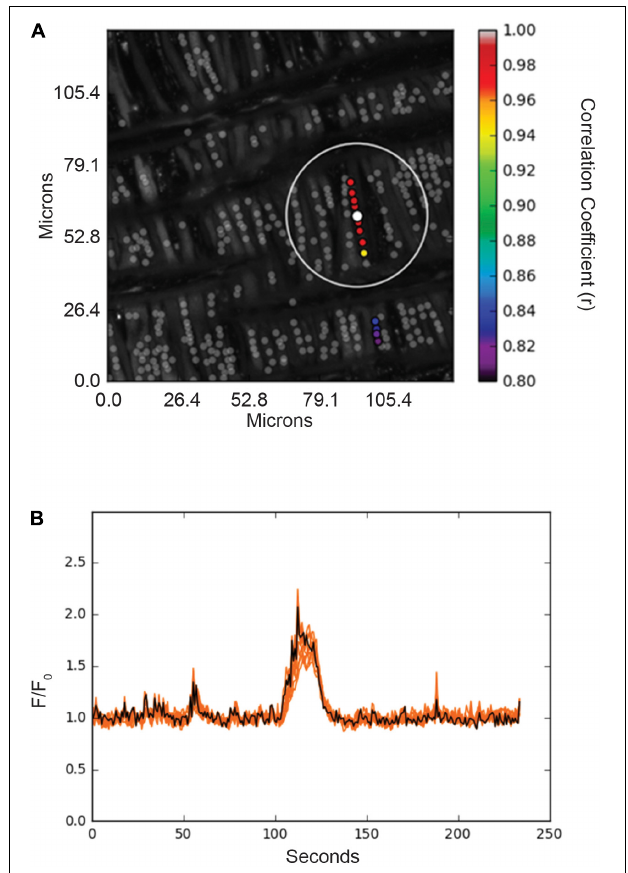
FIGURE 6 | Spatial and temporal correlations of Ca 2 + responses in basilar arterial myocytes from an adult sheep recorded en face under basal conditions. (A) Maximum intensity projection for Fluo-4 fluorescence of recorded cells using laser scanning confocal microscopy. Highly correlated events are colored and plotted around the center (reference) region of interest (ROI, white dot). Gray dots show ROIs of spontaneous Ca 2 + oscillations that showed less than an 80% temporal correlation with the white ROI. The large white open circle shows a ∼ 23 µ m boundary that was used for deriving spatial correlation measurements shown for the spatial and temporal analysis in Figure 7 . (B) Fluorescence intensity tracing showing spontaneous Ca 2 + oscillations, with the black line being the average tracing and the orange lines being the individual ROIs. ROIs were plotted using correlation coefficients with greater than 80% temporal correlation plotted surrounding the center ROI (white dot in A ). Key shows the degree of correlation of each ROI relative to the reference